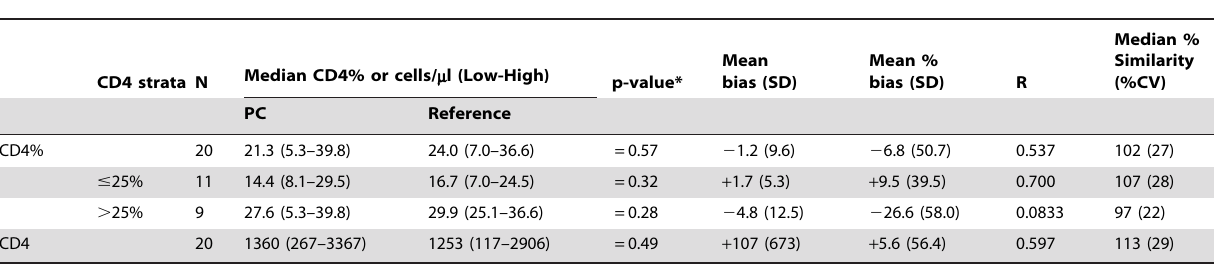
Table 4. Bias between reference method and PointCare Now (PC) for